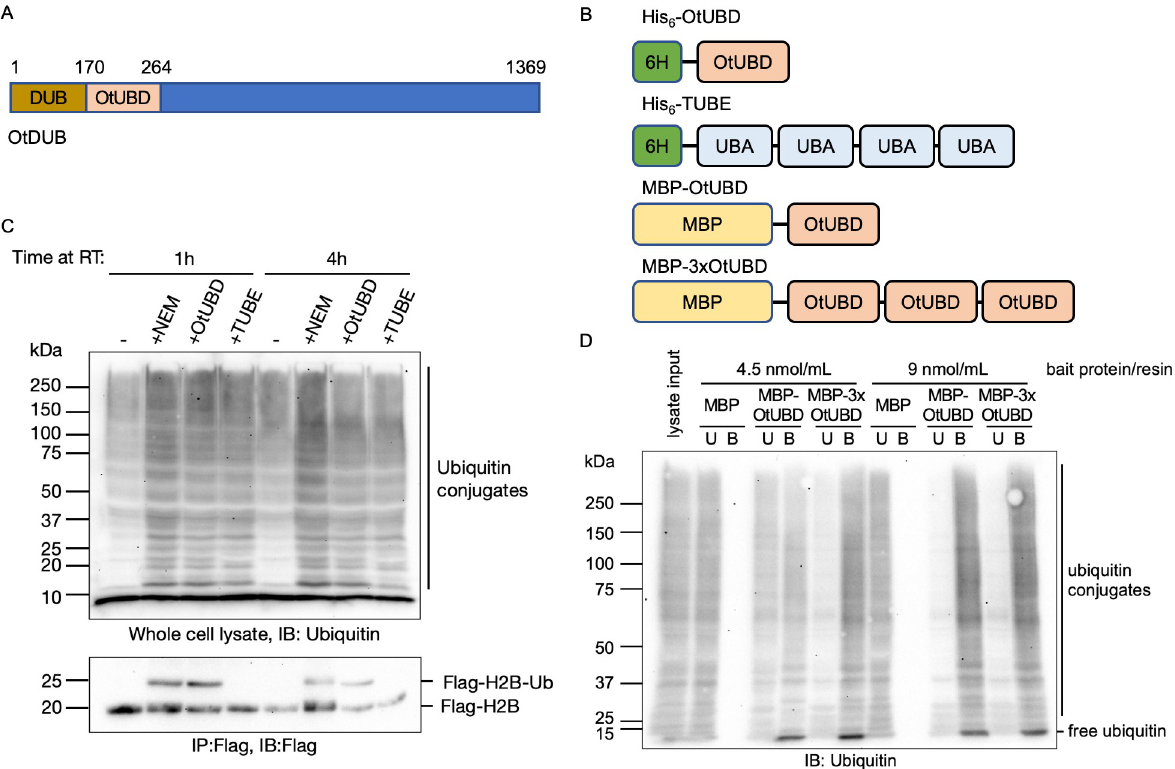
Fig 1. The high-affinity UBD from OtDUB efficiently protects and enriches for yeast ubiquitylated species. (A) Schematic showing the ubiquitin binding domain (OtUBD) within the O . tsutsugamushi DUB (OtDUB). OtUBD spans residues 170 to 264. (B) The different constructs of OtUBD and the control TUBE derived from the UBA domain of human Ubiquilin 1. His 6 tagged OtUBD and TUBE were used in the ubiquitylation protection experiment shown in Fig 1C and MBP-tagged OtUBD and 3xOtUBD were used in the ubiquitin pulldown experiment in Fig 1D. (C) IB analysis of bulk ubiquitylated proteins (top panel) and histone H2B (bottom panel) from yeast cell lysates prepared in the presence of different reagents. OtUBD prevents deubiquitylation of bulk ubiquitylated substrates (top panel) and monoubiquitylated histone H2B (bottom panel). (D) IB analysis of MBP pulldowns from yeast cell lysates using different bait proteins. MBP or MBP-tagged bait proteins bound to an amylose resin were incubated with yeast lysates, and bound proteins were eluted by incubation in SDS sample buffer. Both OtUBD and 3xOtUBD bound (B) ubiquitylated substrates in the lysates. Concentration of bait protein indicates the amount of bait protein per unit volume of amylose resin. B, bound fraction; IB, immunoblot; MBP, maltose-binding protein; OtDUB, O . tsutsugamushi DUB; TUBE, tandem ubiquitin-binding entity; U, unbound fraction; UBD, ubiquitin-binding